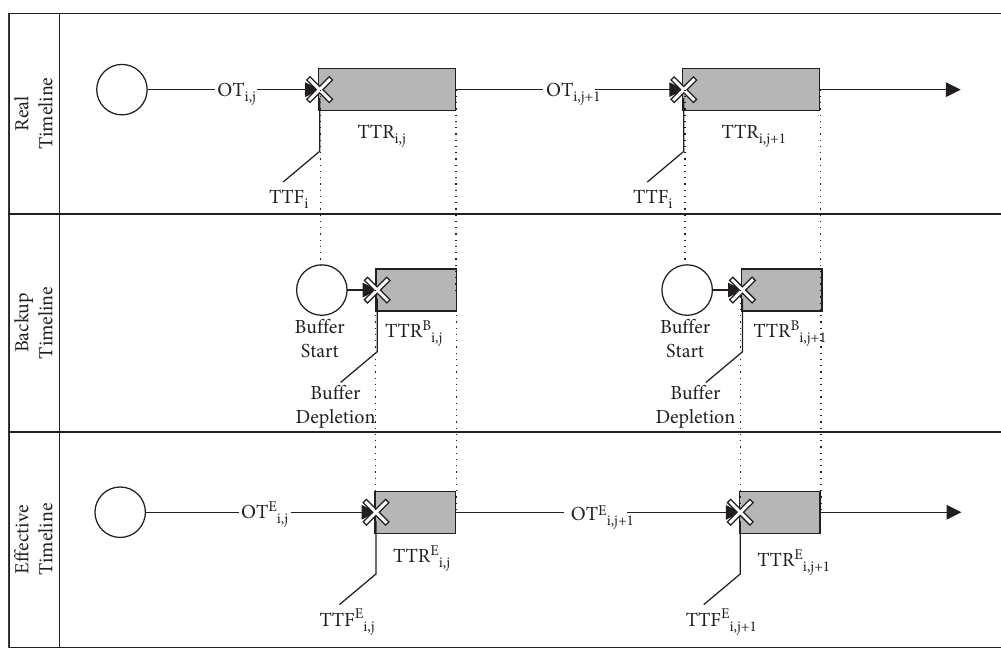
Figure 2: VSB effect on operating time for equipment i